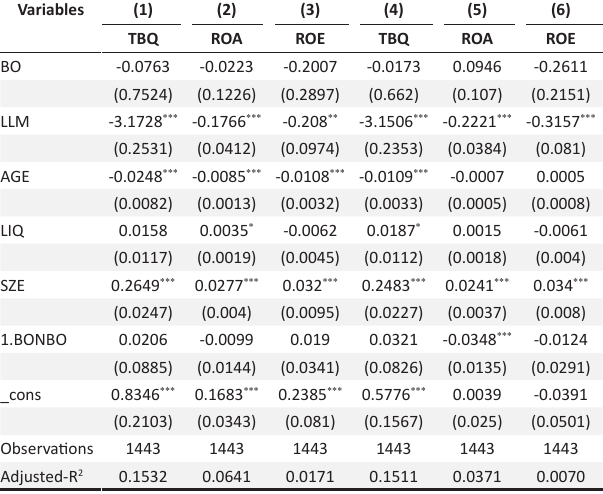
TABLE 5: The effect of black ownership on performance (fixed-effects and random-effects models). Variables